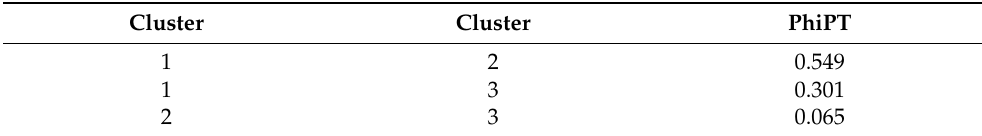
Table 2. Results of the analysis of molecular variance (AMOVA) within and among the groups of 72 melon accessions identified by the discriminant analysis of principal components (DAPC) clustering. SV df SS MS Est. Var. % PhiPT Among Pops 2 24,193.625 12,096.813 648.326 46% 0.463 Within Pops 69 51,826.444 751.108 751.108 54% Total 71 76,020.069 1399.434 100% SV, source of variation; df, degrees of freedom; SS, sum of squares; MS, mean square; Est. Var., estimated variance; %, percentage of variation. Table 3. Pairwise genetic differentiation values among the clusters. Cluster Cluster PhiPT 1